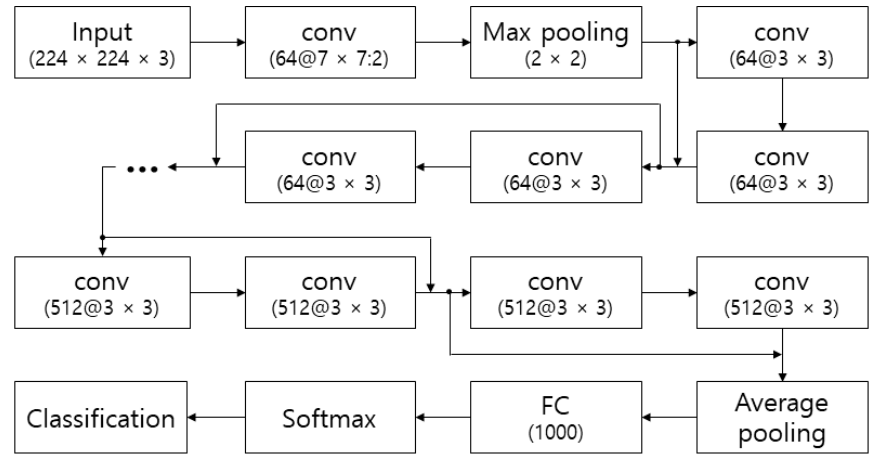
Figure 2. Structure of ResNet.